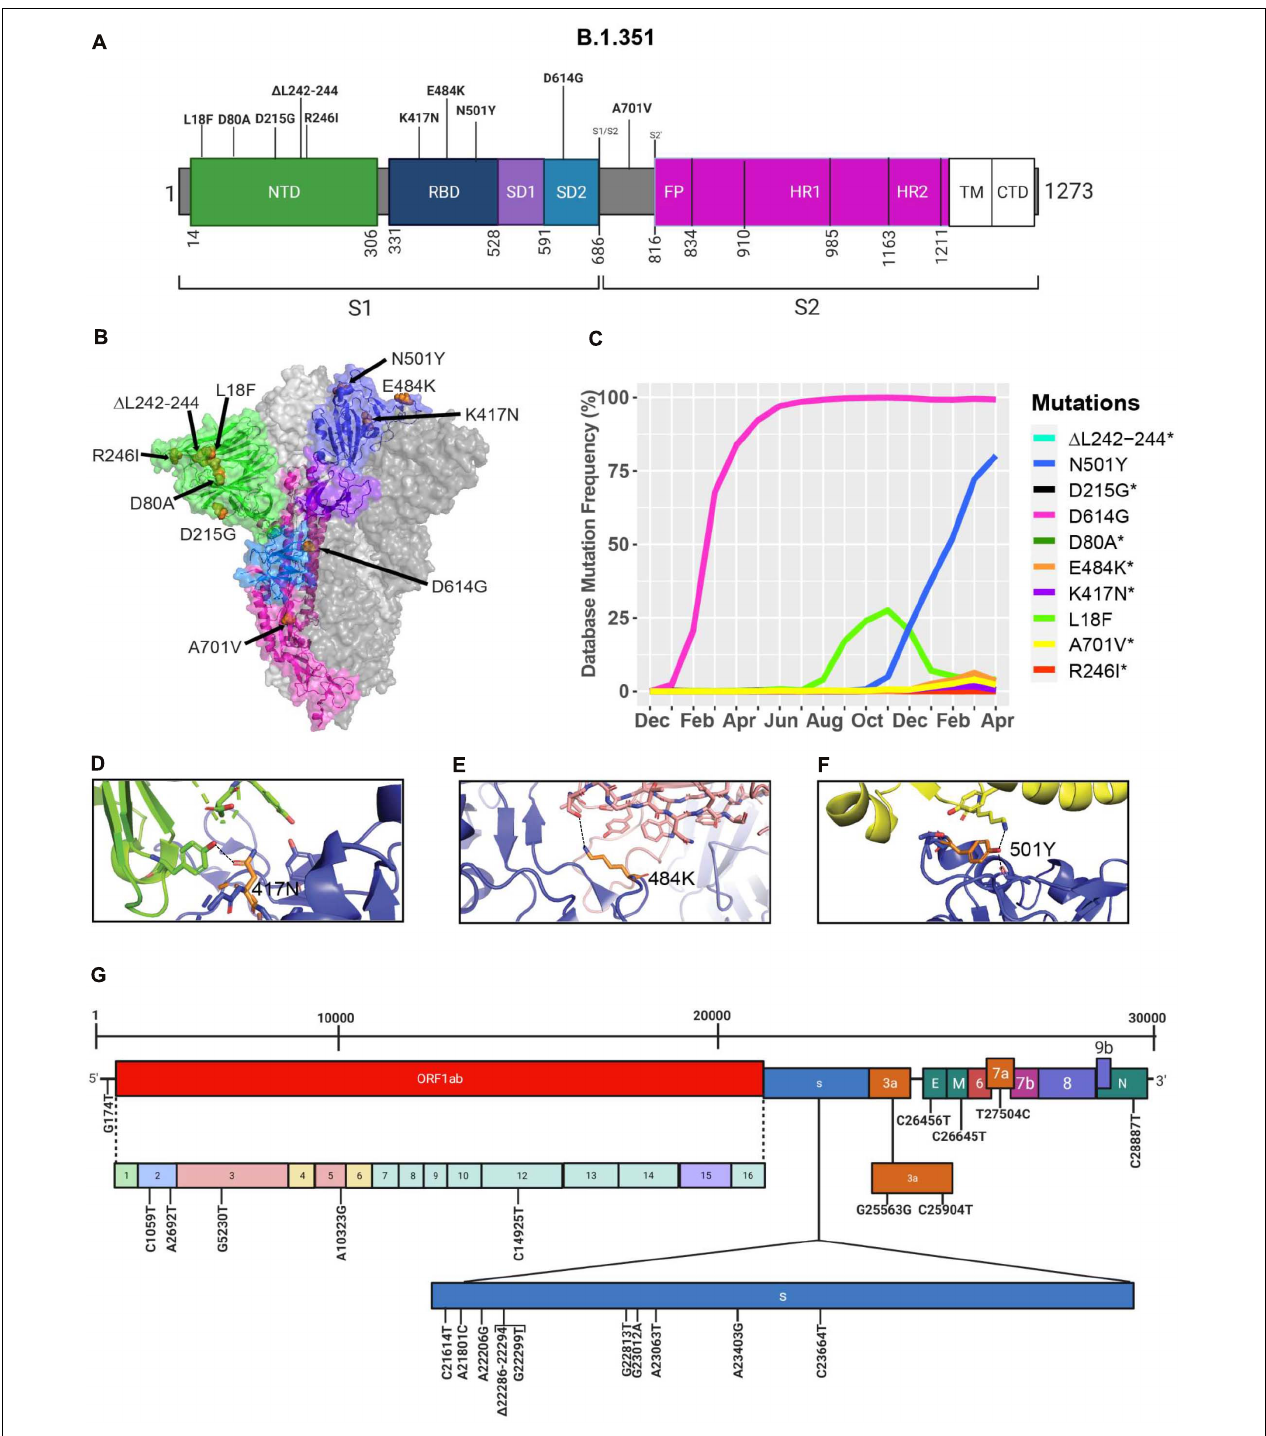
FIGURE 7 | Analysis of mutations in the B.1.351 variant. (A) Mutation map of the spike protein of B.1.351. (B) Structural representation of spike with ACE2. B.1.352 S protein mutations are presented in orange. NTD (green), RBD (blue), SD1 (purple), SD2 (light blue), and S2 (magenta) are illustrated. The other S protein monomers are illustrated in gray and white. (C) Frequency of the mutations in the S protein B.1.351 variant from December 2019 to April 30, 2021. Interaction of (D) 417N with C102 Nab (green), (E) 484K with C121 Nab (light pink), and (F) 501Y with hACE2 (yellow). The mutant residues are illustrated in orange, and the dashed lines represent interactions with adjacent residues. (G) Genome of the SARS-CoV-2 B.1.351 variant with identified nucleotide substitutions or deletions. Graphs were generated using Biorender, PyMOL, and RStudio. *Overlapping